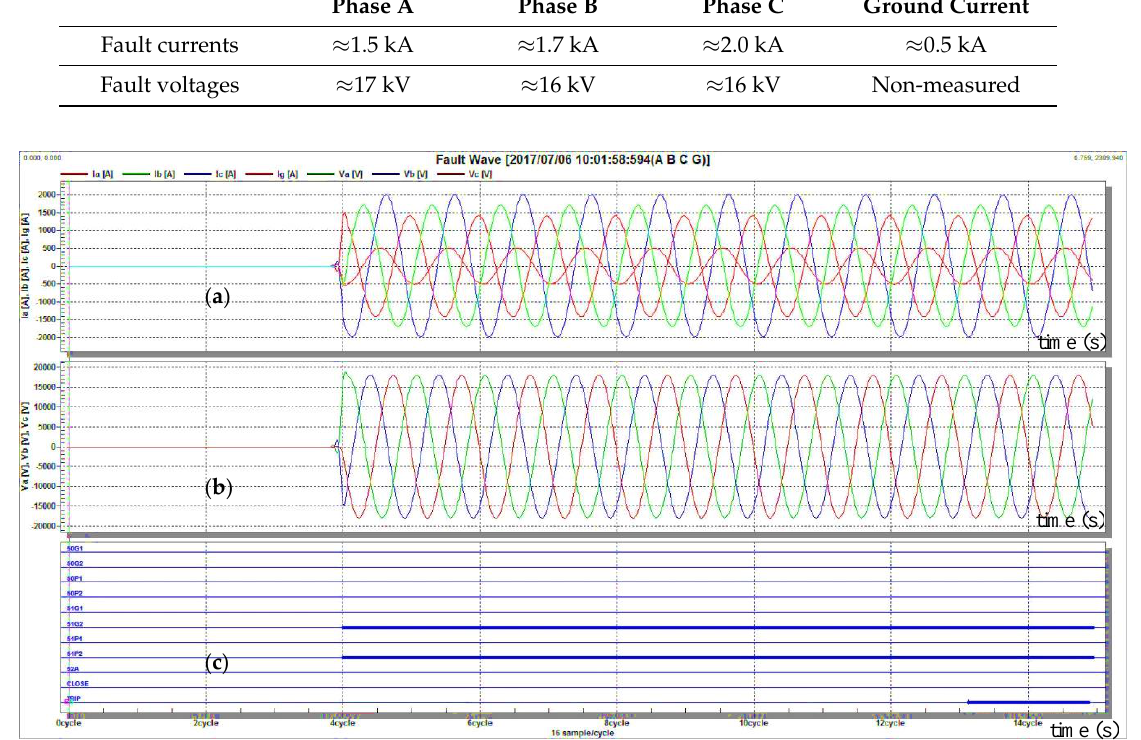
Figure 10. Fault waveforms corresponding to a TPGF at F3: ( a ) three phase currents, Ia (A), Ib (A), Ic (A), and a ground current Ig (A)); ( b ) three phase voltages, Va (V), Vb (V), and Vc (V); ( c ) tripping signals of the Co-Co recloser (51P2 and 51G2 are respectively phase and ground tripping signals; a TRIP signal shows the tripping action implemented by the recloser). Table 20. The operation status of overcurrent relays and reclosers with a TPGF at F3.